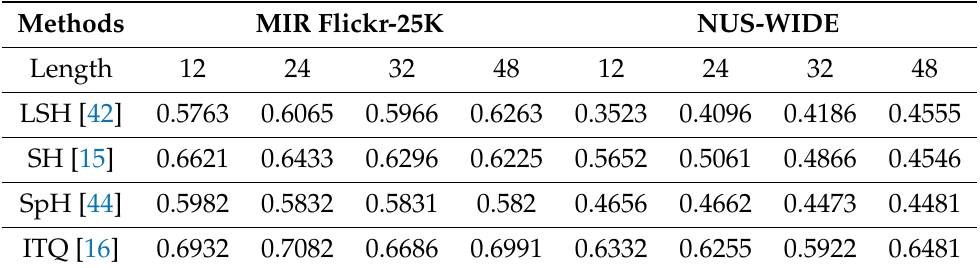
Table 3. MAP results for the MIR Flickr-25K and NUS-WIDE datasets, using hash codes of different lengths, were calculated using the first 5000 images